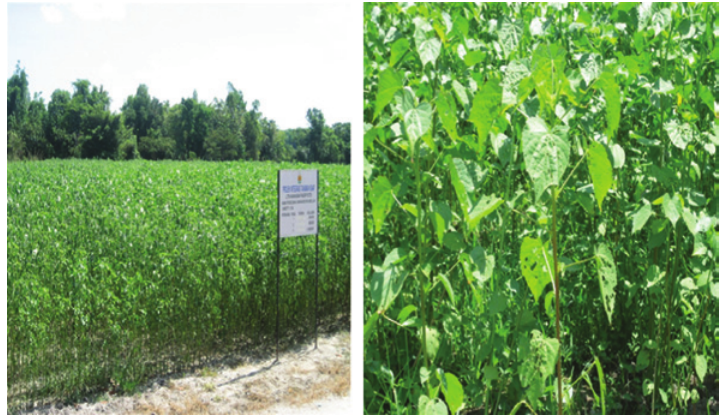
Figure 9: Kenaf plants [21]. Table 5: Physical and mechanical properties of kenaf fiber [22].